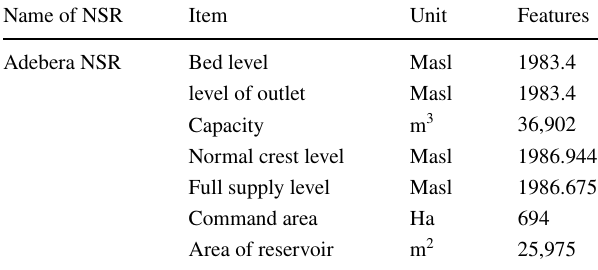
Table 1 Salient features of the Adebra night storage